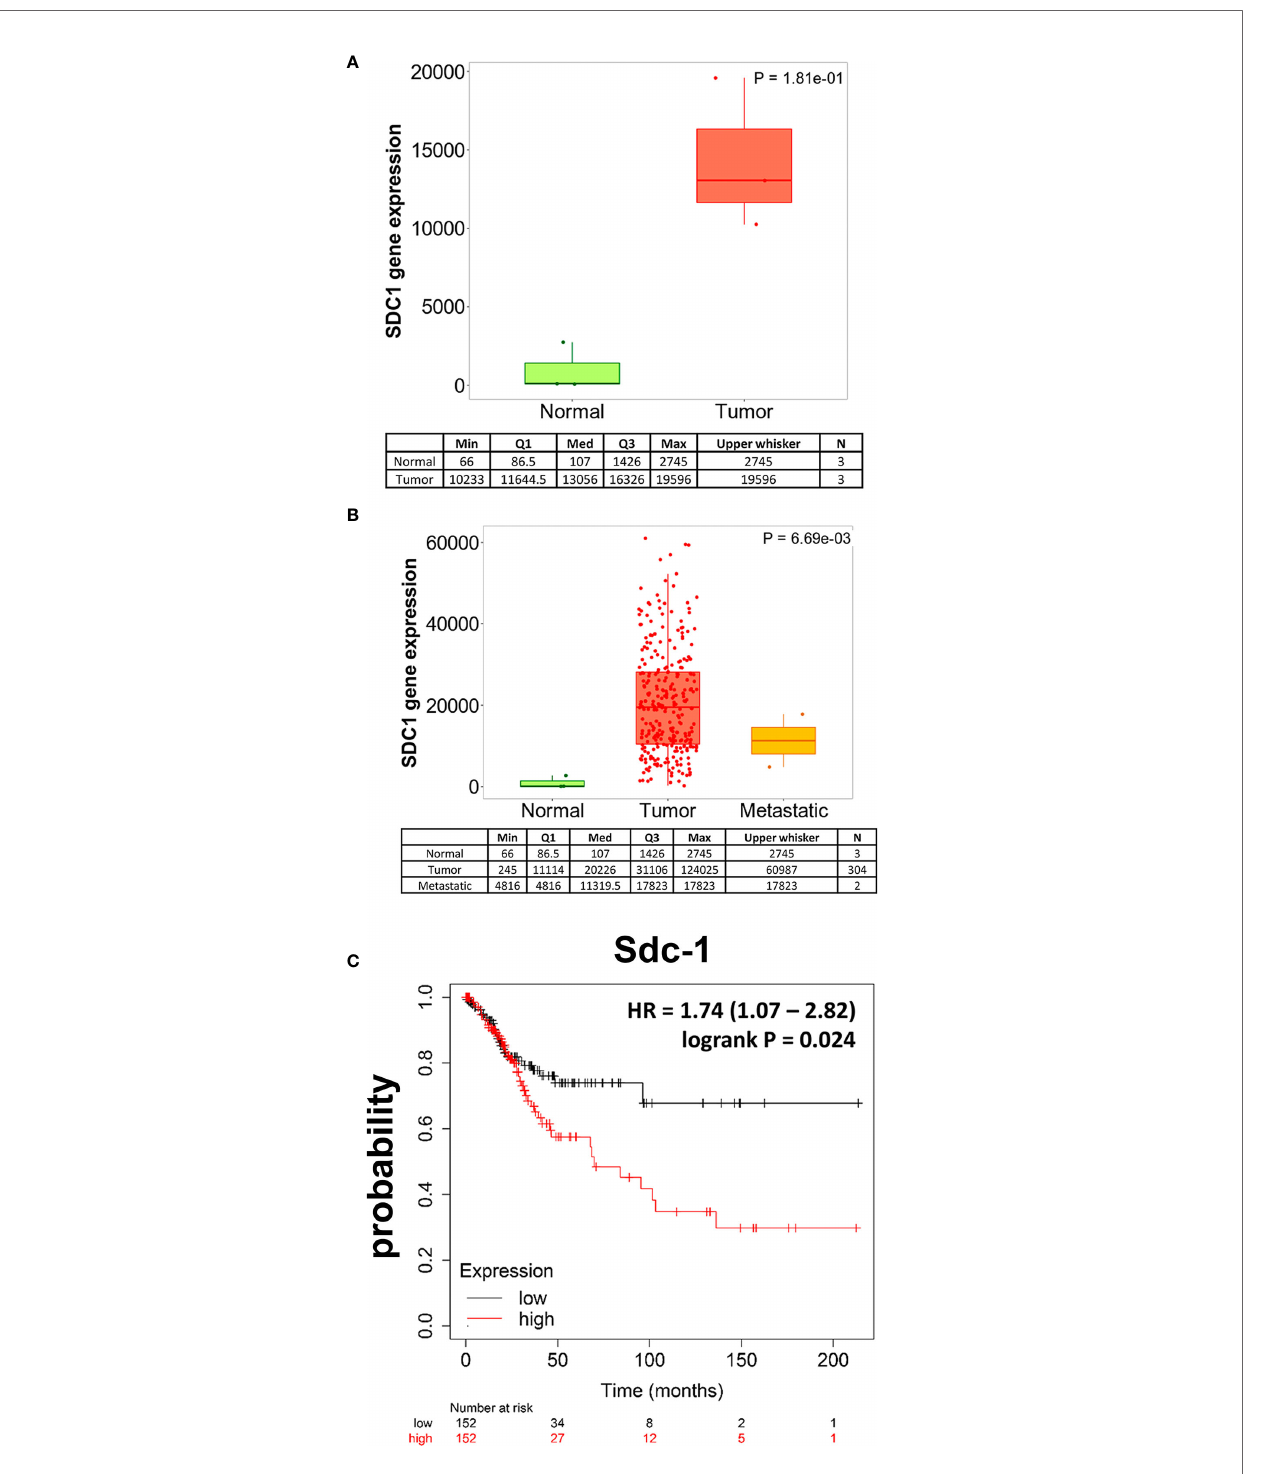
FIGURE 1 | Sdc-1 is dysregulated in cervical carcinoma, and its high expression correlates with poor overall survival. Boxplots of SDC-1 gene expression in cervical cancer tissue when comparing paired normal and tumor RNA Seq data of three patients. (A) and when comparing normal, tumor and metastasis RNA Seq data (B) . The quantile cutoff values (minimum, 1st quartile, median, 3rd quartile, maximum) and the number of analyzed samples are presented. (C) Kaplan-Meier Survival analysis of 304 cervical carcinoma patients strati fi ed by high or low expression of Sdc-1. (A) p=0.181 (not signi fi cant), Mann-Whitney-Test. (B) p=0.069 (Kruskal- Wallis test, trend for signi fi cance), post hoc -analysis p-values (Dunn ’ s test): p=1.65x10 -03 normal tissue compared to tumors (signi fi cant), p=0.175 tumor tissue compared to metastases (not signi fi cant), p=0.115 normal tissue compared to metastatic tissue. (C) p=0.024 (signi fi cant), Cox regression analysis log rank